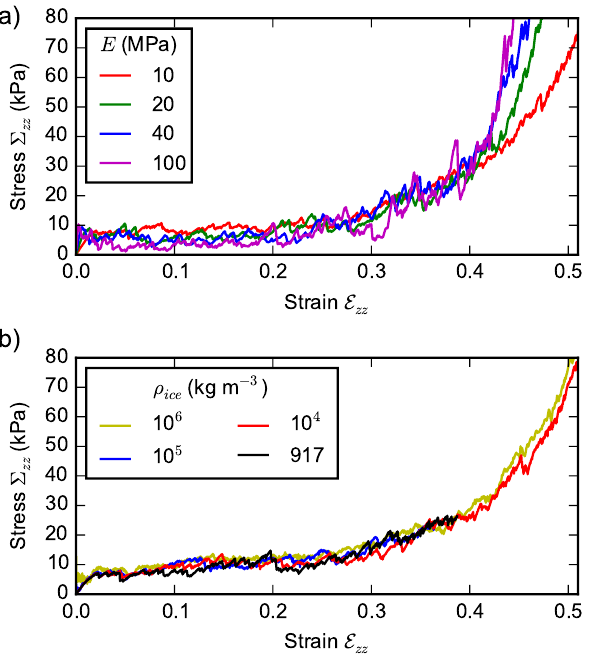
Figure 9. Computed stress–strain curves for different Young’s mod- uli (a) and ice densities (b) .